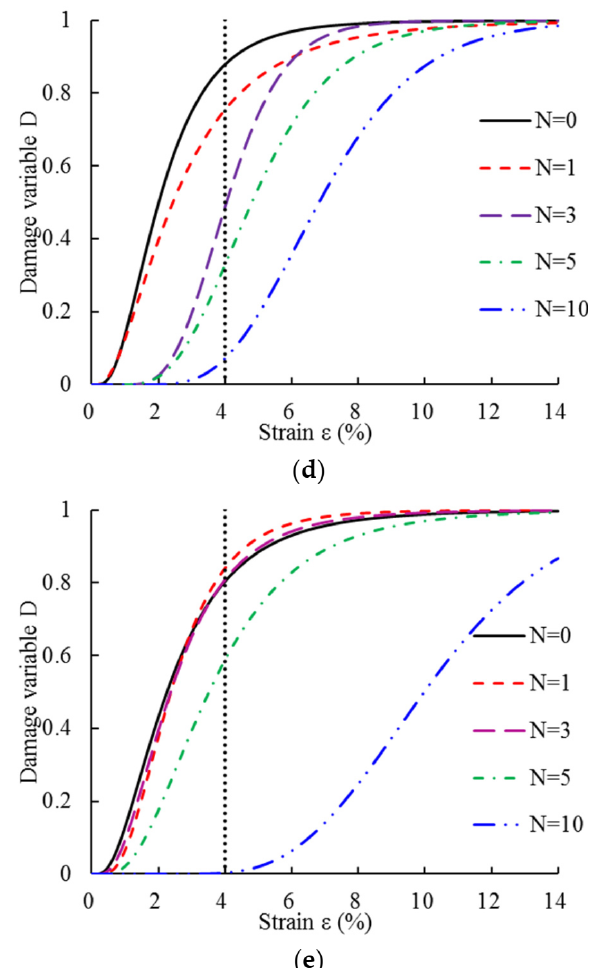
Figure 11. Damage evolution curves of the FCMS. ( a ) Damage evolution curves of FCMS with 0% fiber content; ( b ) Damage evolution curves of FCMS with 0.25% fiber content; ( c ) Damage evolution curves of FCMS with 0.5% fiber content; ( d ) Damage evolution curves of FCMS with 0.75% fiber content; ( e ) Damage evolution curves of FCMS with 1% fiber